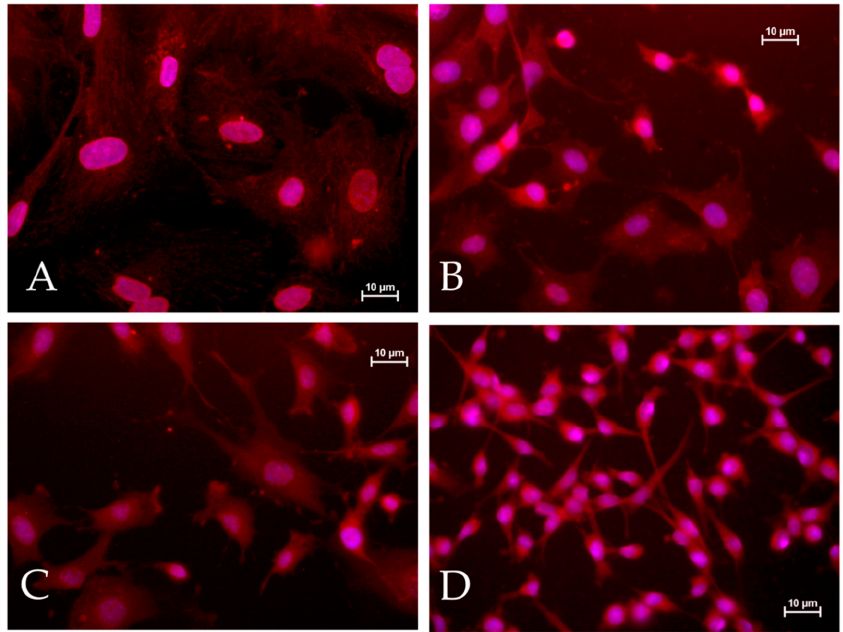
Figure 1. Immunofluorescent analysis of glial fibrillary acidic protein (GFAP) expression in primary astrocytes ( A ), A-GS1 clone ( B ), A-VV5 clone ( C ), and A-FC6 clone ( D